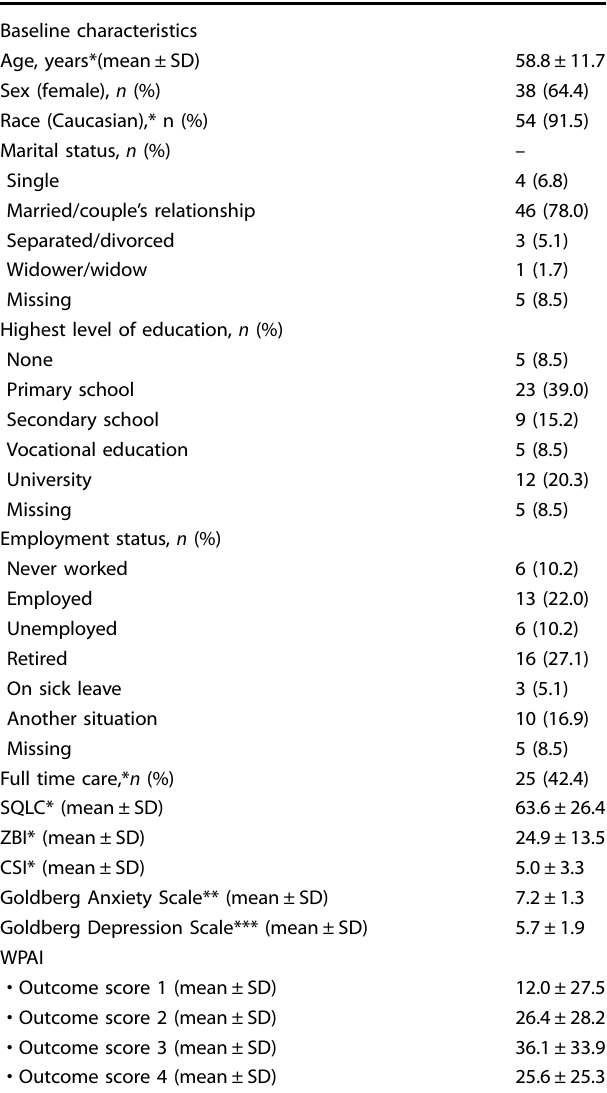
Table 2. Baseline sociodemographic characteristics of caregivers and global scores of SQLC, ZBI, CSI, Goldberg Anxiety Scale, Goldberg Depression Scale, and WPAI. Baseline